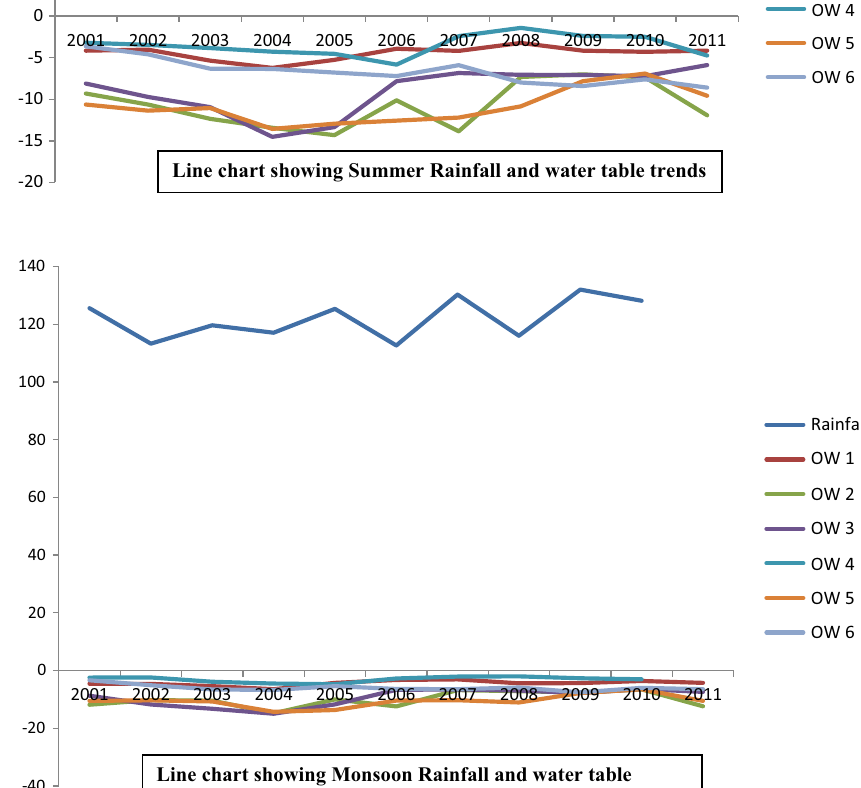
Line chart showing Monsoon Rainfall and water table